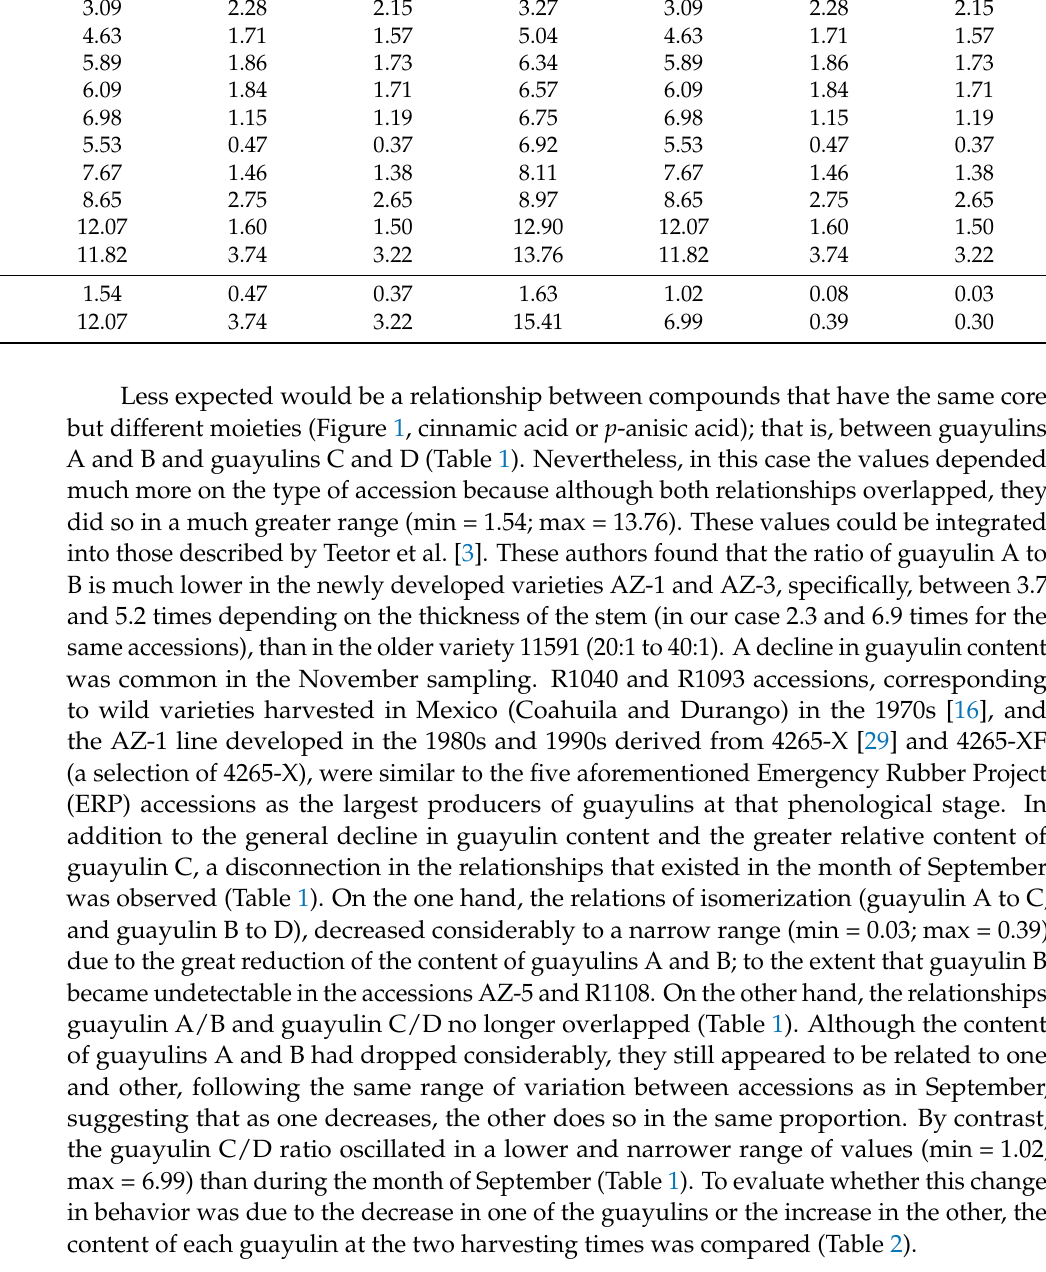
Table 1. Relationship between guayulins (A, B, C and D) for each harvesting time depending on guayule accession.